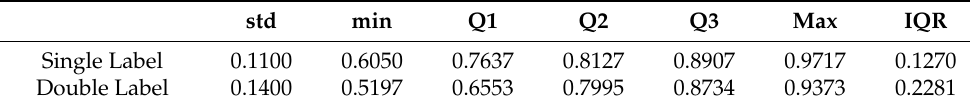
Table 2. The AUC value comparison of using unilateral and bilateral labels. std min Q1